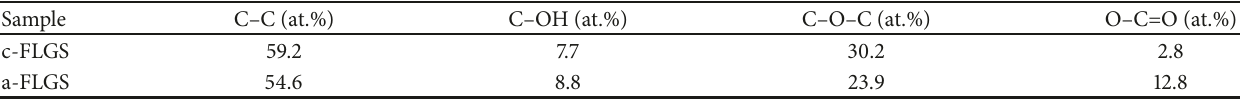
Table 1: C1s peak data for c-FLGS and